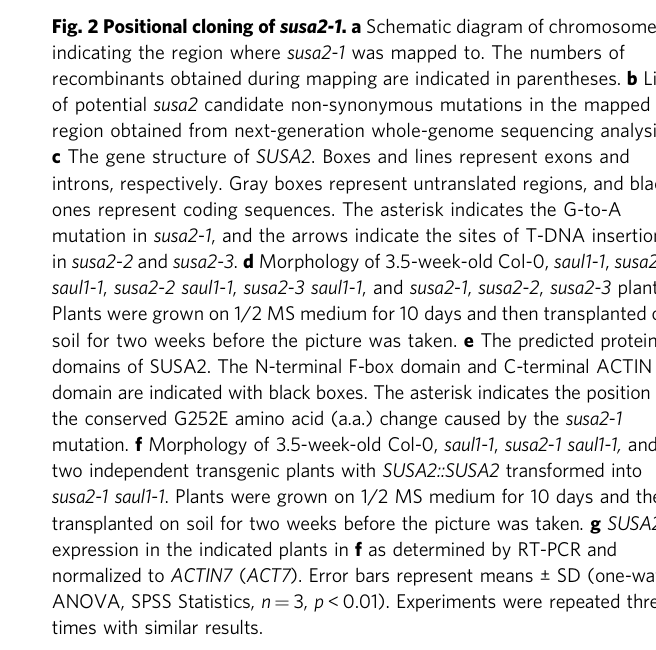
phenotype of saul1-1 . Transgene complementation was further performed to con fi rm the correct cloning of SUSA3 by transforming the native HSP90.3::HSP90.3 into susa3-1 saul1-1 mutants 37 . As shown in Fig. 3d, e, HSP90.3::HSP90.3 reverted susa3-1 sau11-1 back to saul1-1 phenotype. Taken together, SUSA3 is HSP90.3 .